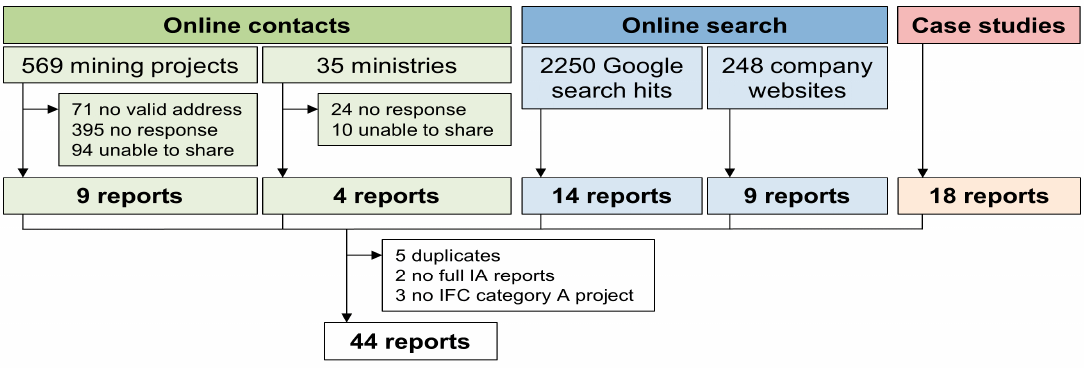
Figure 1. Sources and flow chart of impact assessment reports. IA = impact assessment; IFC = International Finance